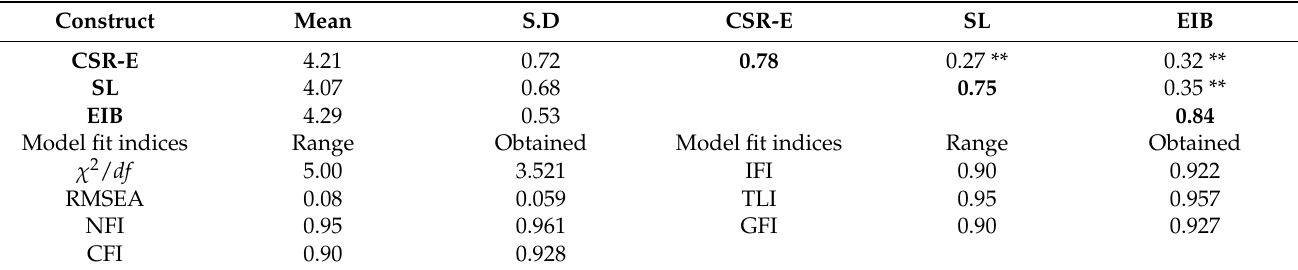
Table 3. Correlation, discriminant validity, and model fit indices.